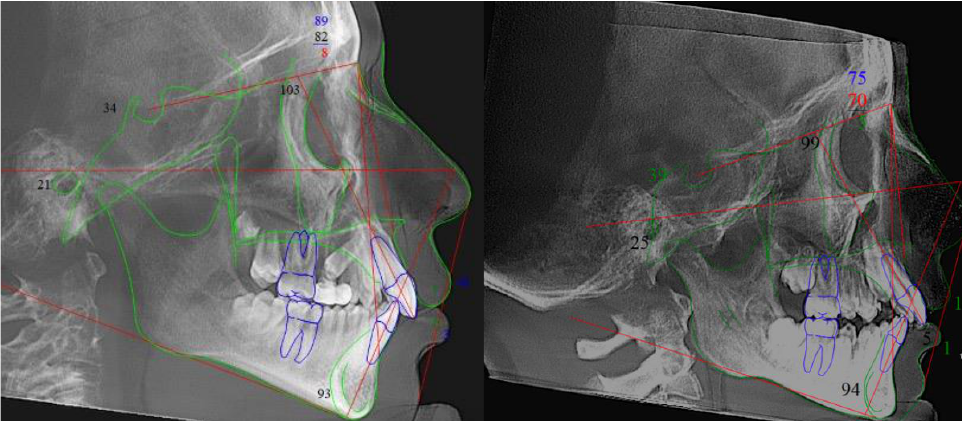
Figure 1. Cephalometric images rendered from CBCT DICOM data and traced using Dolphin Imaging. The ( left ) is a patient from the control group and the ( right ) is a patient from the JIA group.